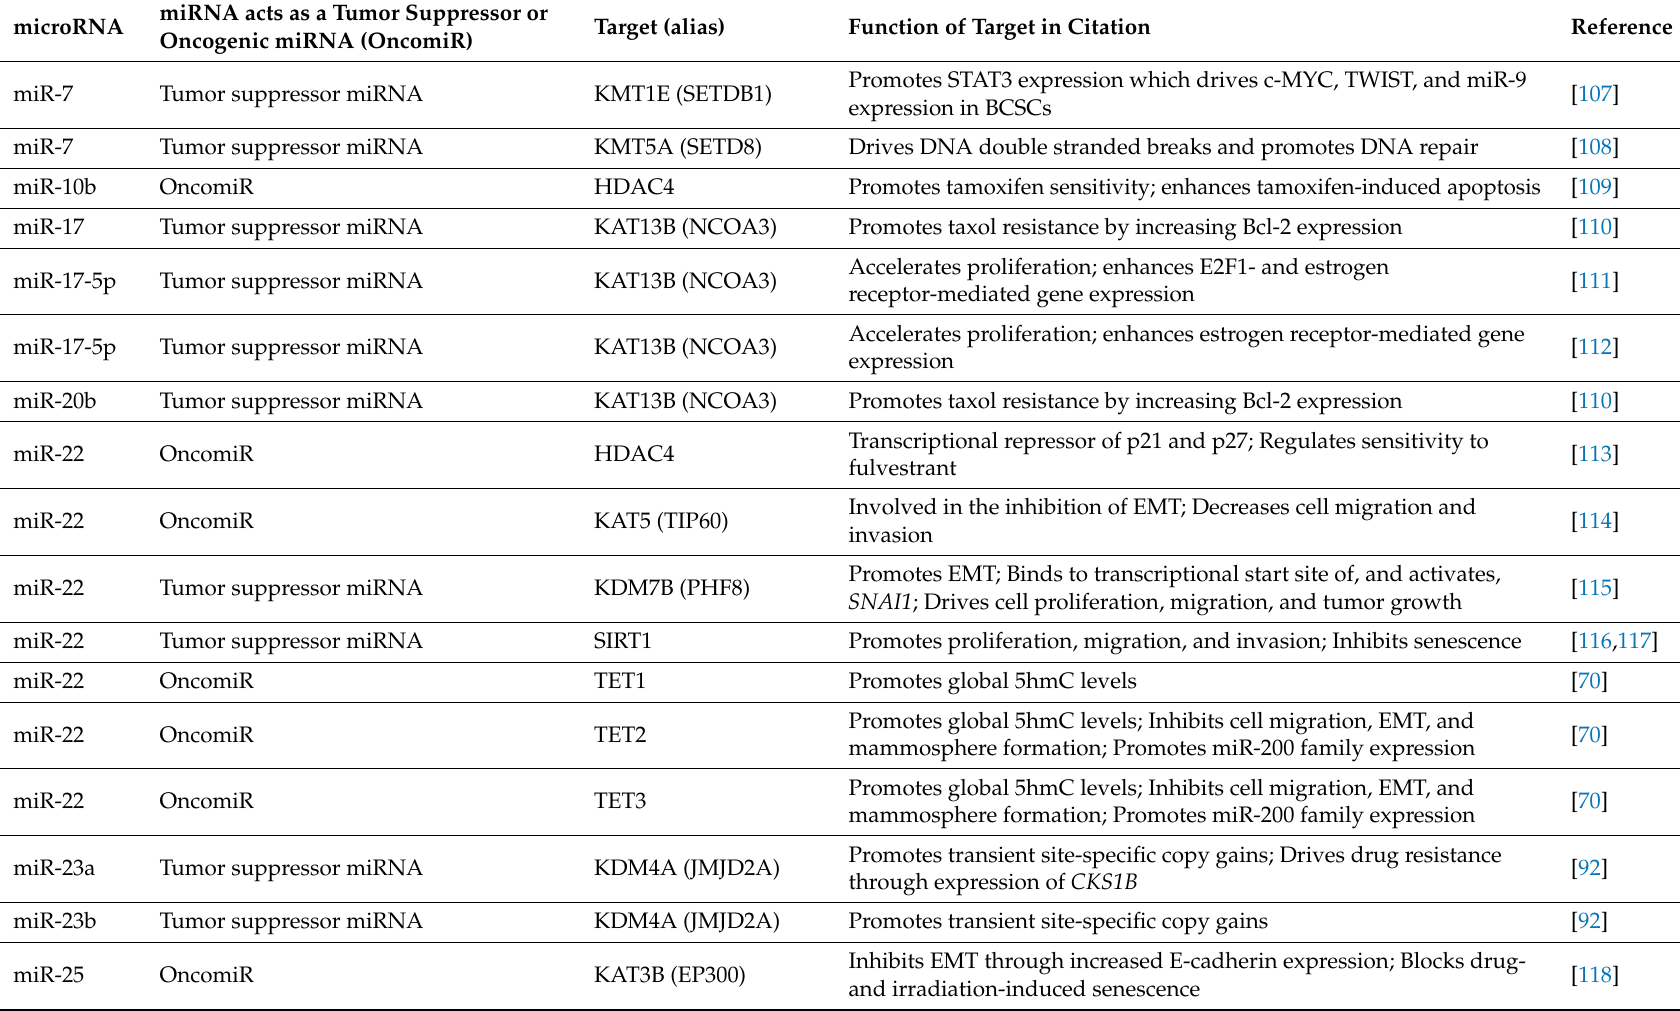
Table 2. Epigenome regulators targeted by microRNAs in breast